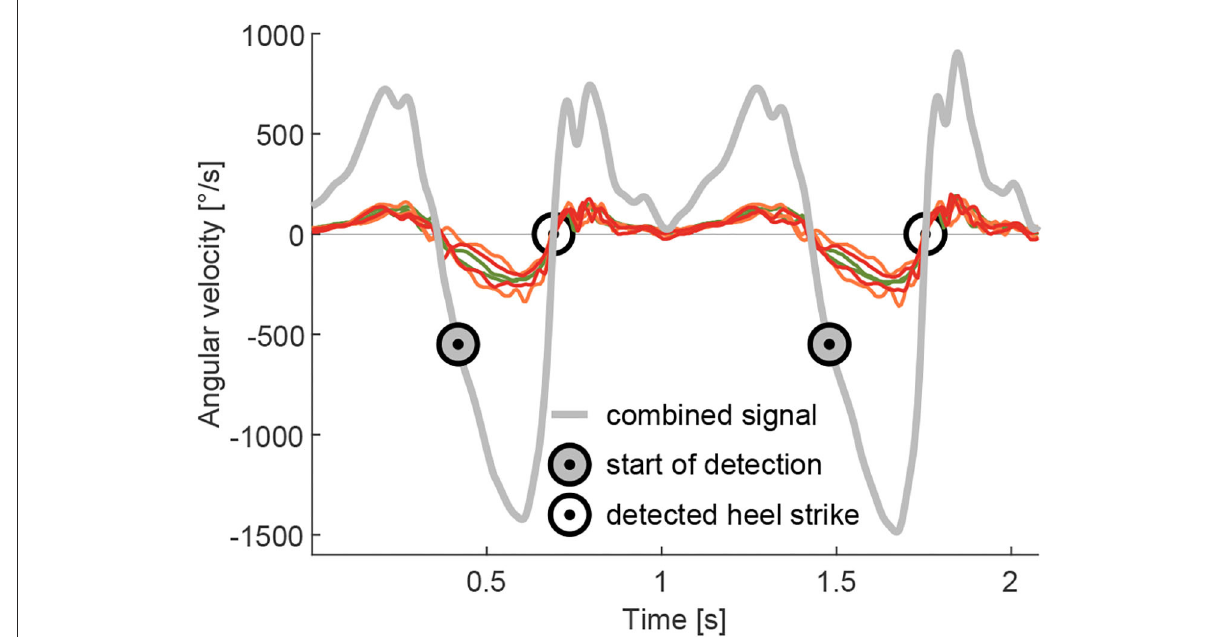
FIGURE4 Example for the combined signal of the angular velocity during walking. The combined signal is the sum of the two axes, which include the movement in the sagittal plane, of the gyroscopes, integrated into the GAS (organe), SOL (red), and TIB (green) sensors. The combined signal was used for the detection of the heel strike to separate individual strides. The heel strike detection starts at an angular velocity of –550°/s and identifies the following passing of zero, which is used as a heel strike